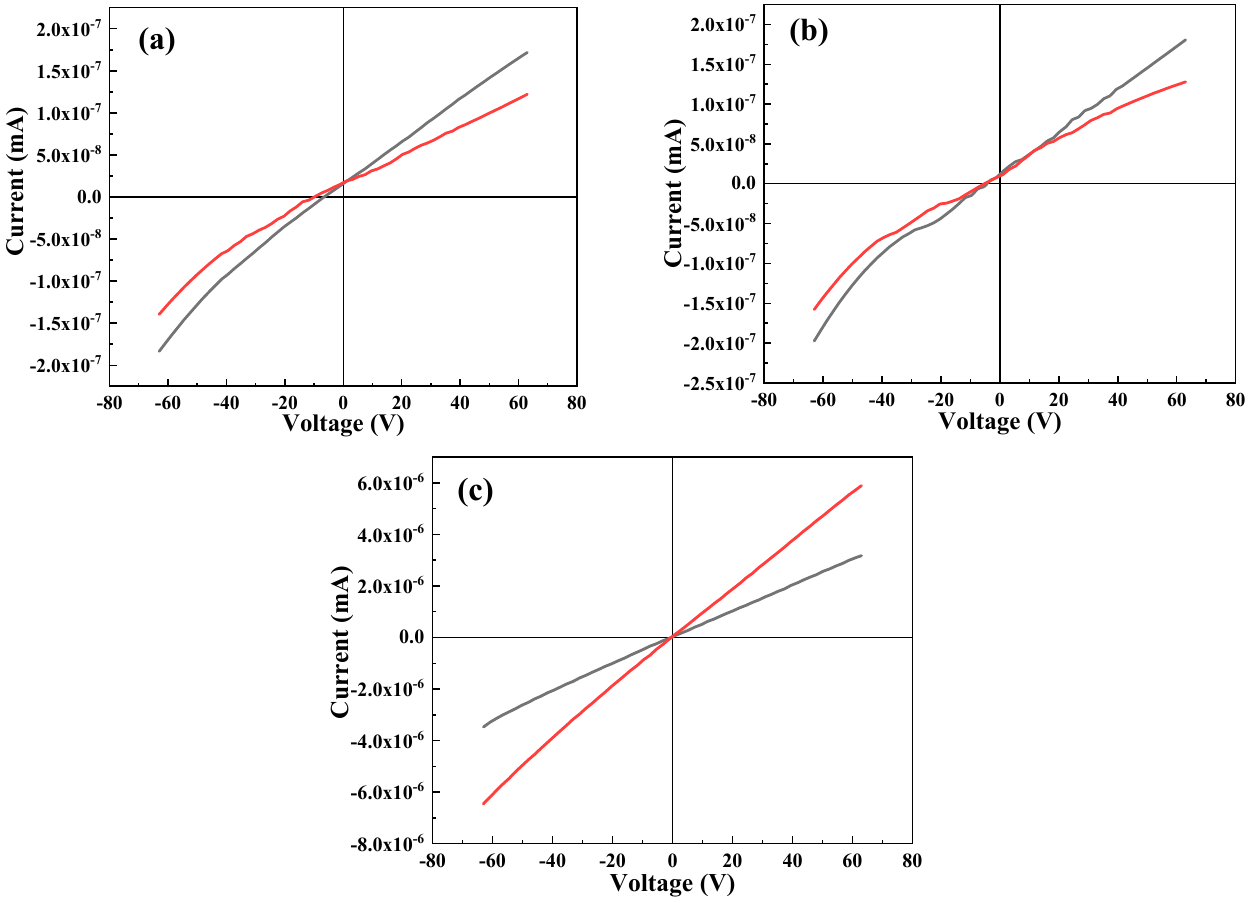
Figure 8. IV study of ( a ) 0 at.% Cr, ( b ) 1. 0 at.% Cr, and ( c ) 3.0 at.% Cr.